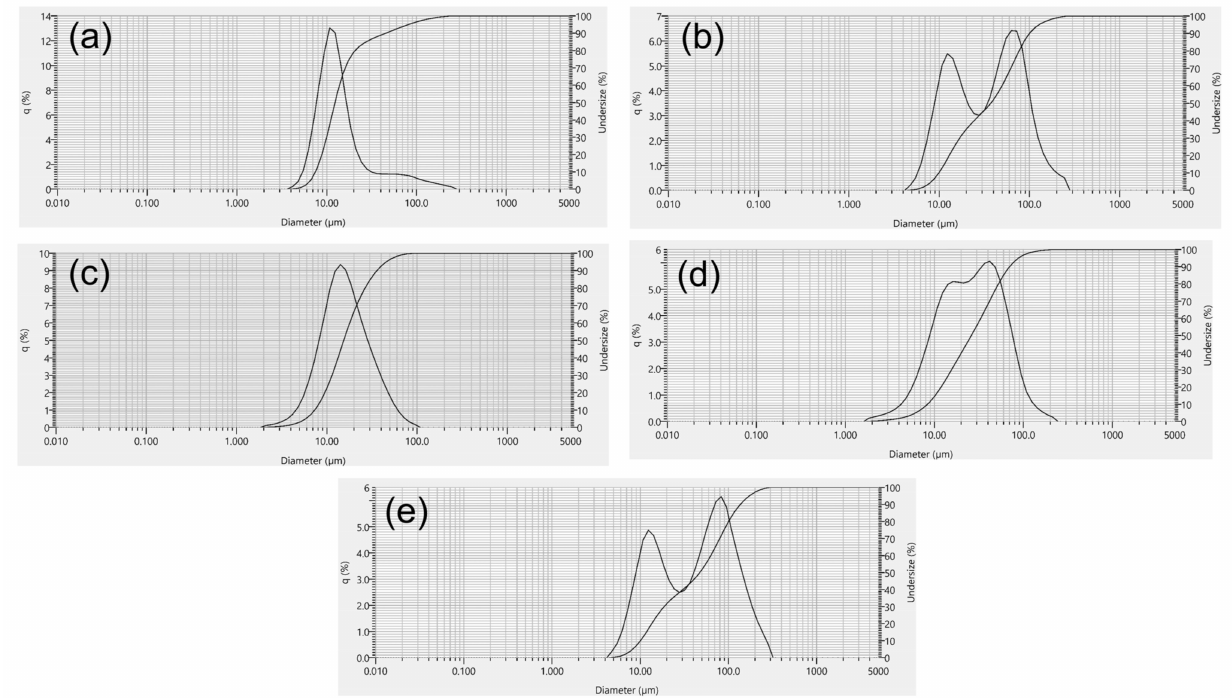
Figure 6. Particle size distribution of ( a ) SiO 2 ( b ) SiO 2 /Zr ( c ) SiO 2 -TEDTA ( d ) SiO 2 /Zr-TEDTA and ( e ) SiO 2